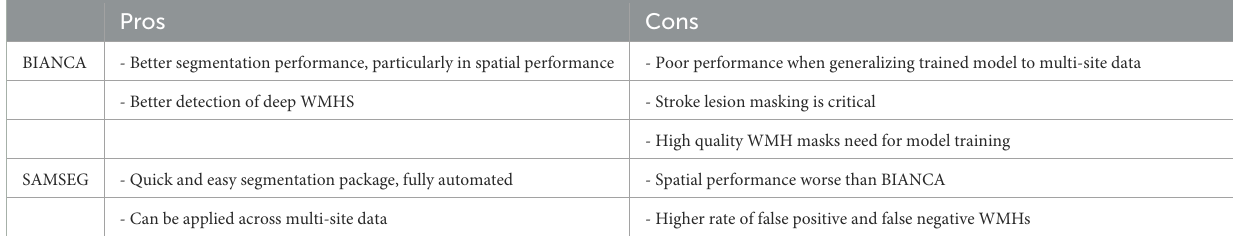
TABLE 3 Comparison of BIANCA and SAMSEG for use in individuals with